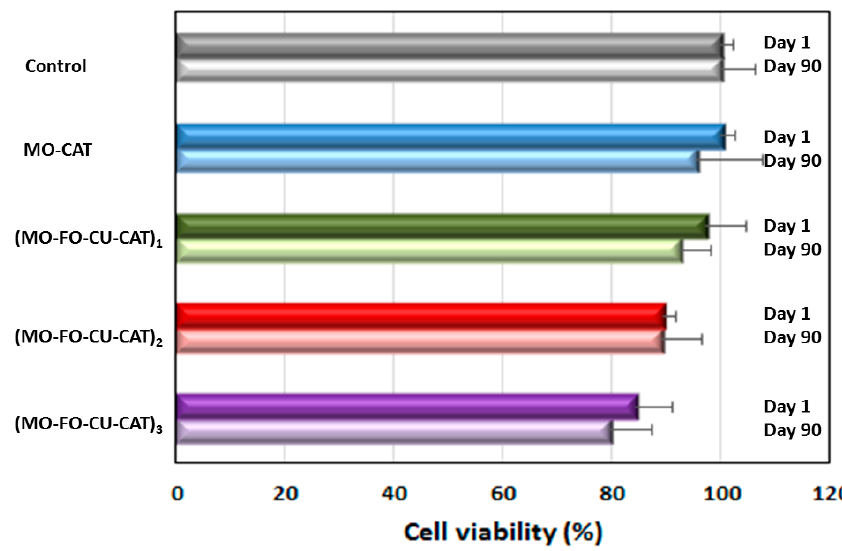
Figure 6. Cellular viability of retinoic acid-differentiated SH-SY5Y cells after 24 h exposure to 0.5 μ M of catalase-loaded liquid crystalline nanoparticles. The histograms at Day 1 and Day 90 correspond to the time elapsed (one day or 90 days) after the nanoparticles’ preparation before cell exposure. The MO-FO-CU-CAT compositions are presented in section 4.3 of Methods.